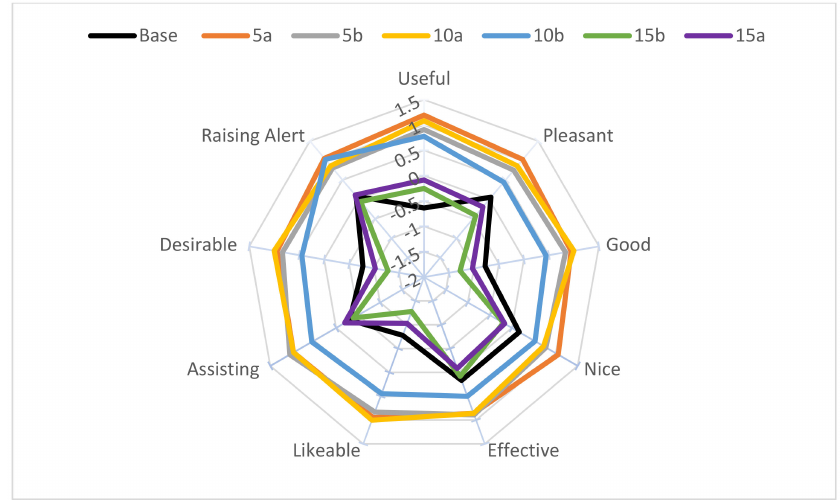
Figure 8. Van der Lann acceptance score for the overtaking vehicle